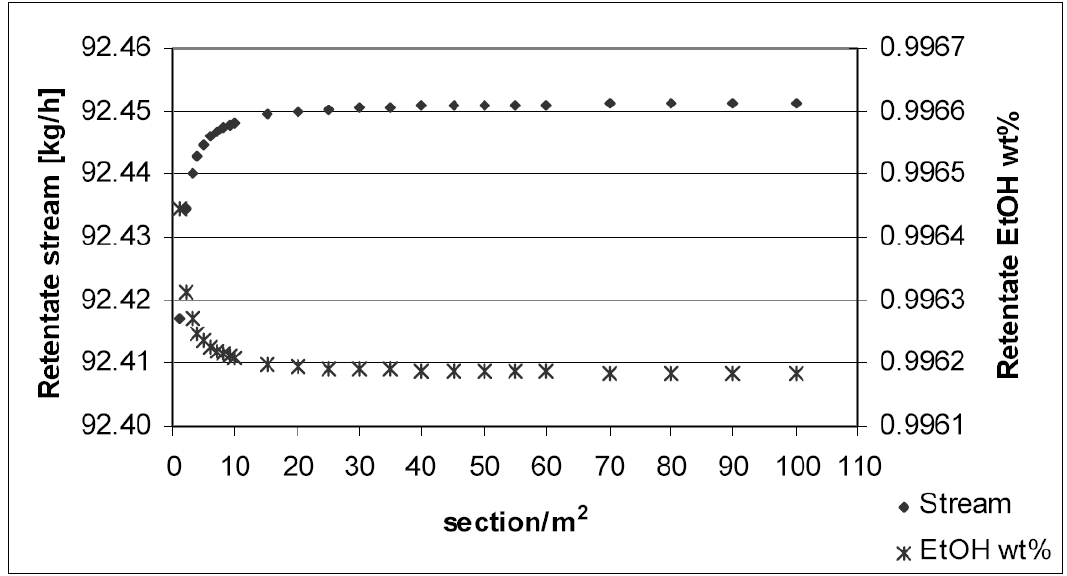
Fig. 2 Changes with number of membrane